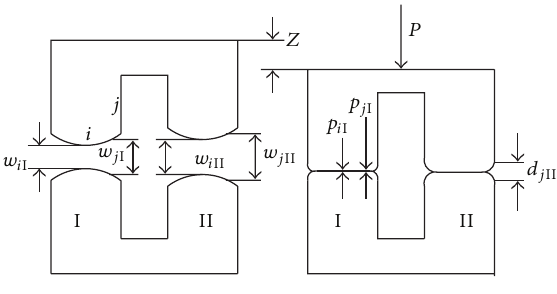
Figure 3: Load tooth contact analysis